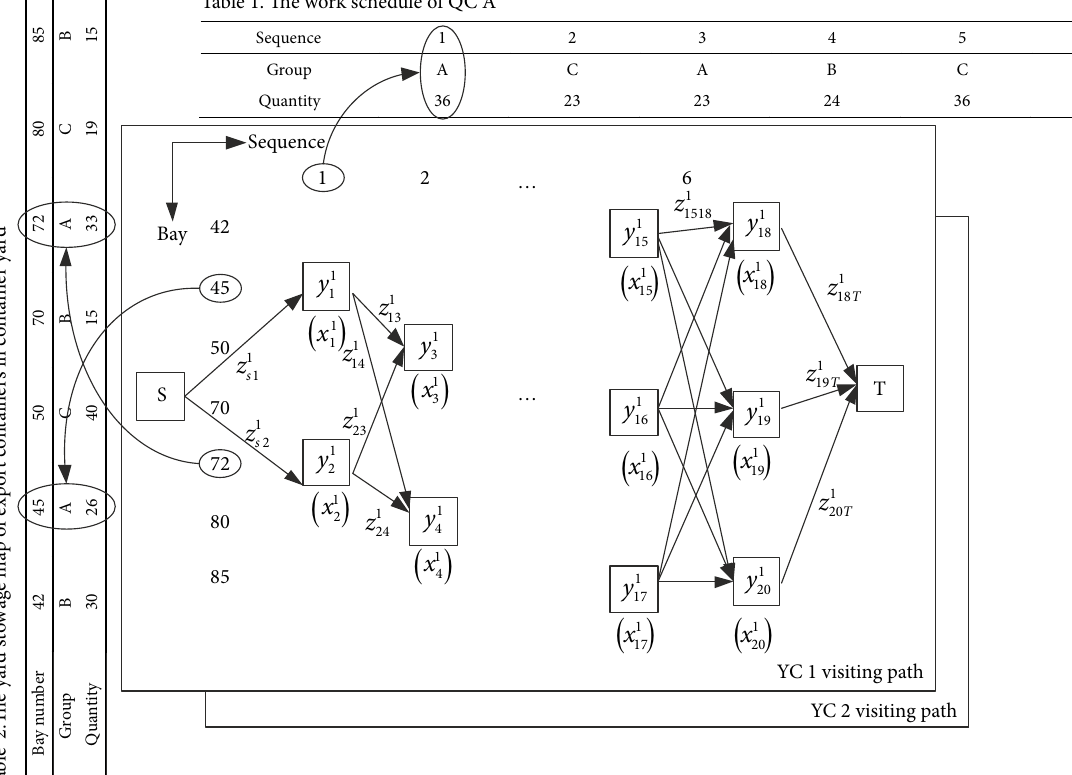
Fig. 3. The time-space networks of the visiting paths of two